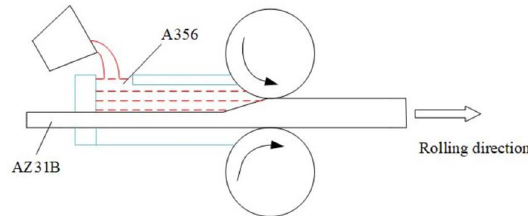
Figure 1. Schematic diagram of the rolling